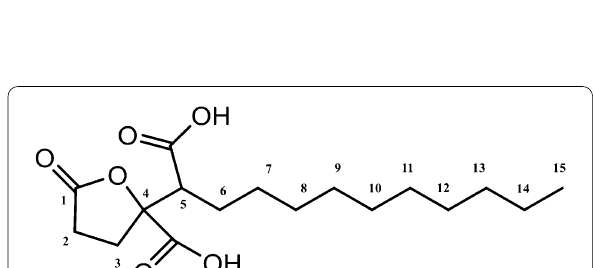
Fig. 4 The structure of spiculisporic acid produced from T. trachyspermus NBRC 32238